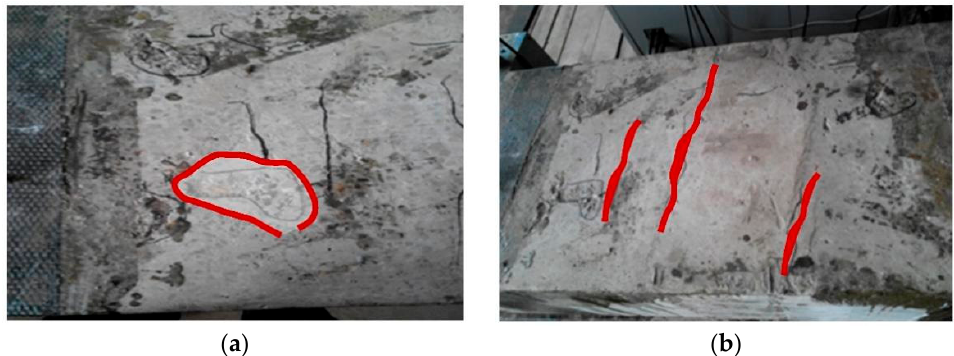
Figure 11. Damage diagram of test plate reinforced by carbon fiber cloth during fatigue testing: ( a ) local crushing after 2 million fatigue cycles at the roof; ( b ) damage map of roof concrete.